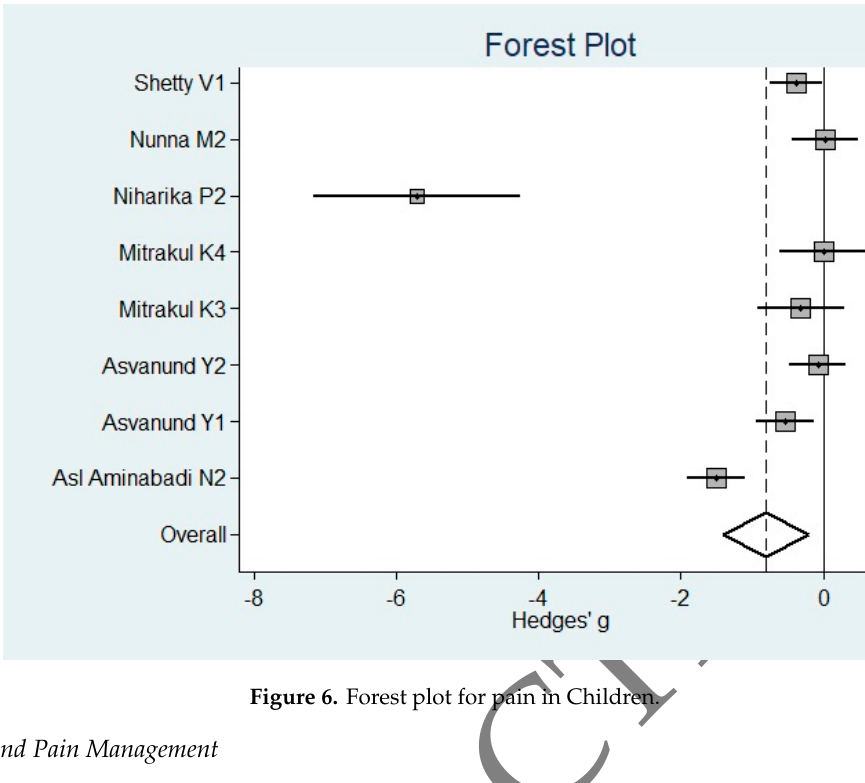
Figure 6. Forest plot for pain in Children.